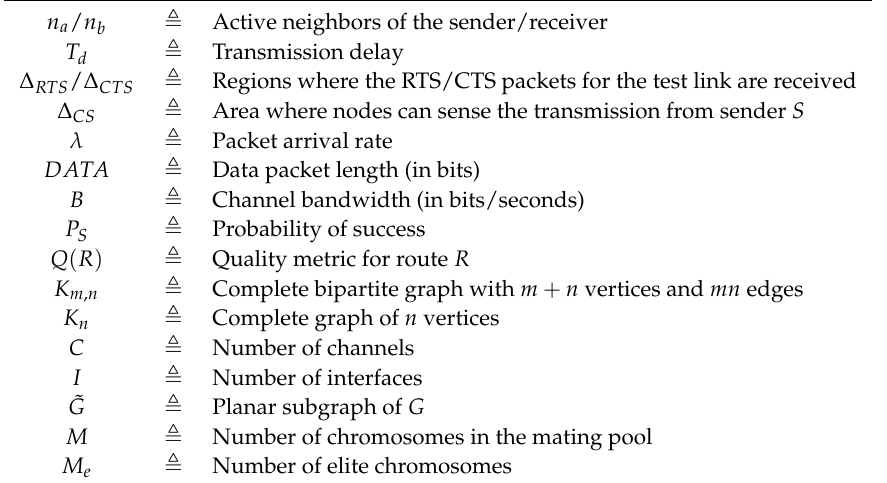
Table 2. Table of